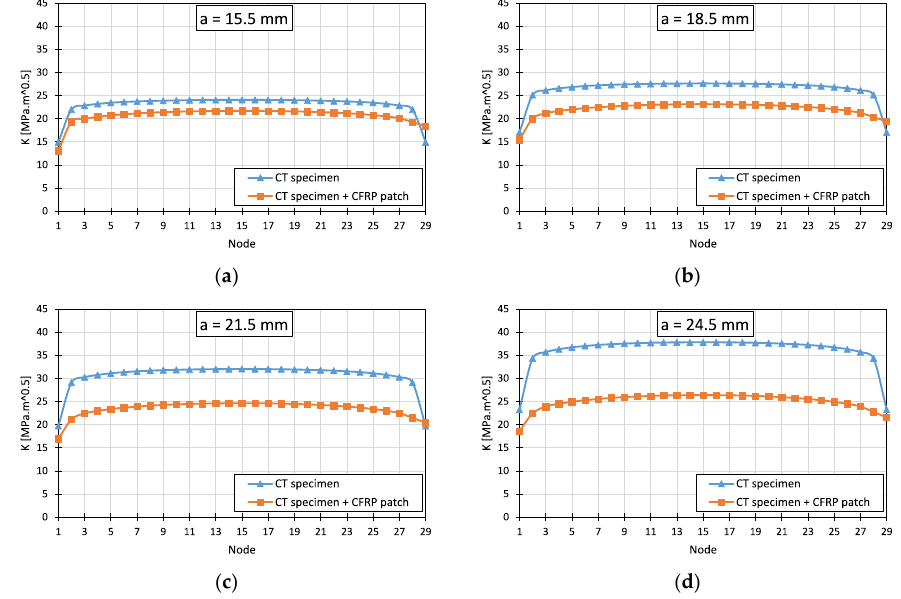
Figure 10. Numerical stress intensity factors for the strengthened and non-strengthened CT specimens, ( a ) variations of stress intensity factors (SIF) for crack length 15.5 mm, ( b ) variations of stress intensity factors (SIF) for crack length 18.5 mm, ( c ) variations of stress intensity factors (SIF) for crack length 21.5 mm, ( d ) variations of stress intensity factors (SIF) for crack length 24.5 mm